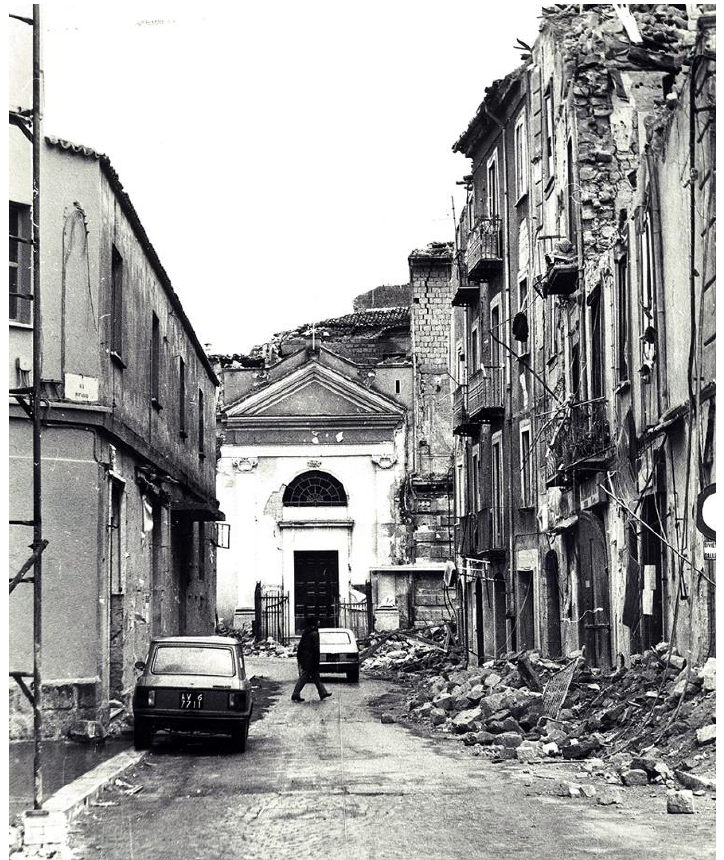
Figure 116. Avellino: Rifugio Street after 1980 earthquake (cortesy of F. Capossela).